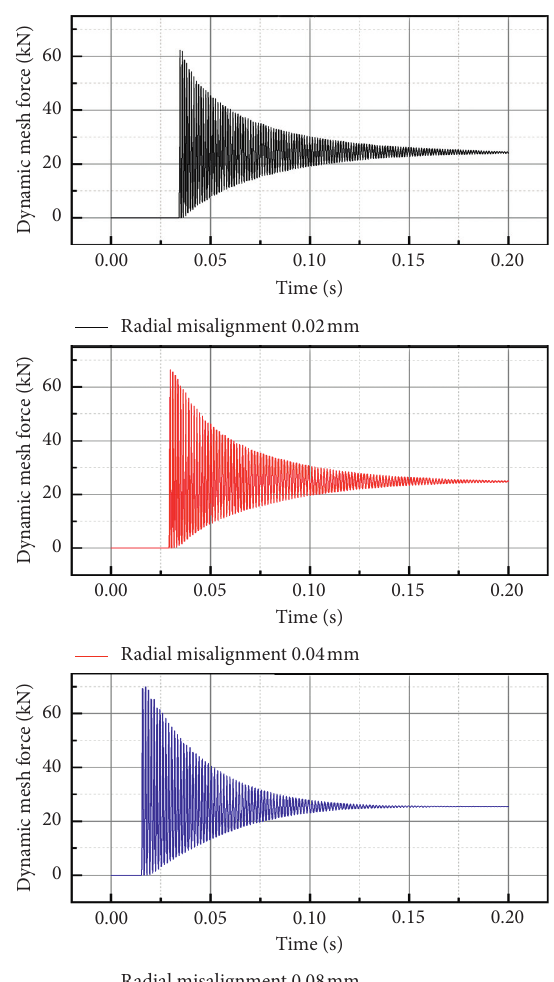
Figure 15: The comparison of meshing force of spline coupling with different radial misalignments δ under identical loading